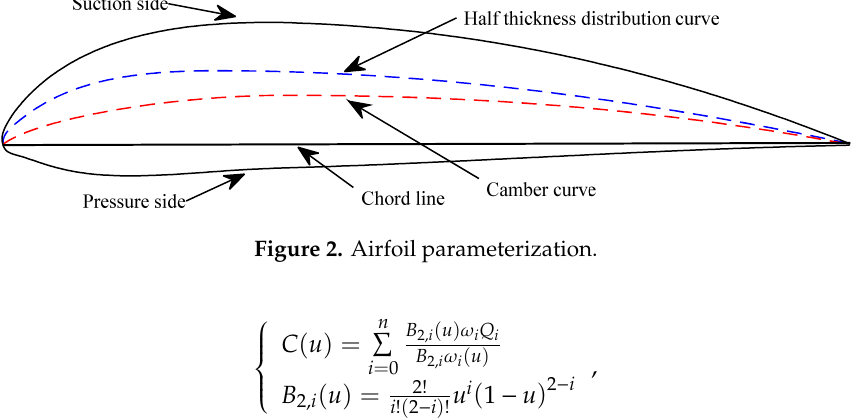
Figure 2. Airfoil Figure 2. Airfoil parameterization.